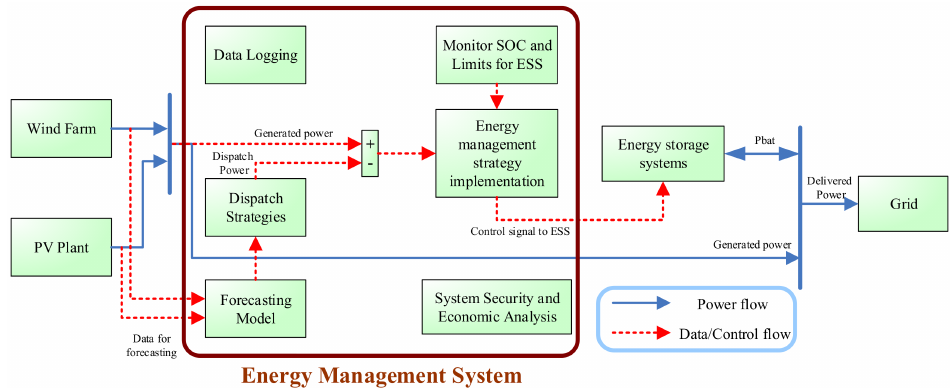
Figure 1. The architecture of the energy management scheme [32].